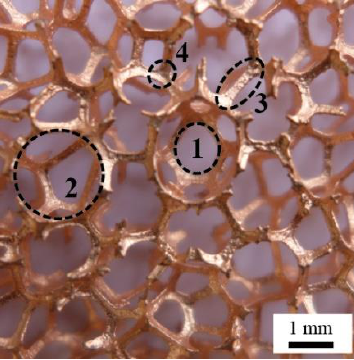
Figure 1. Essential building elements of the open-cell metal foams (1 – pore, 2 – cell, 3 – ligament, and 4 – node).